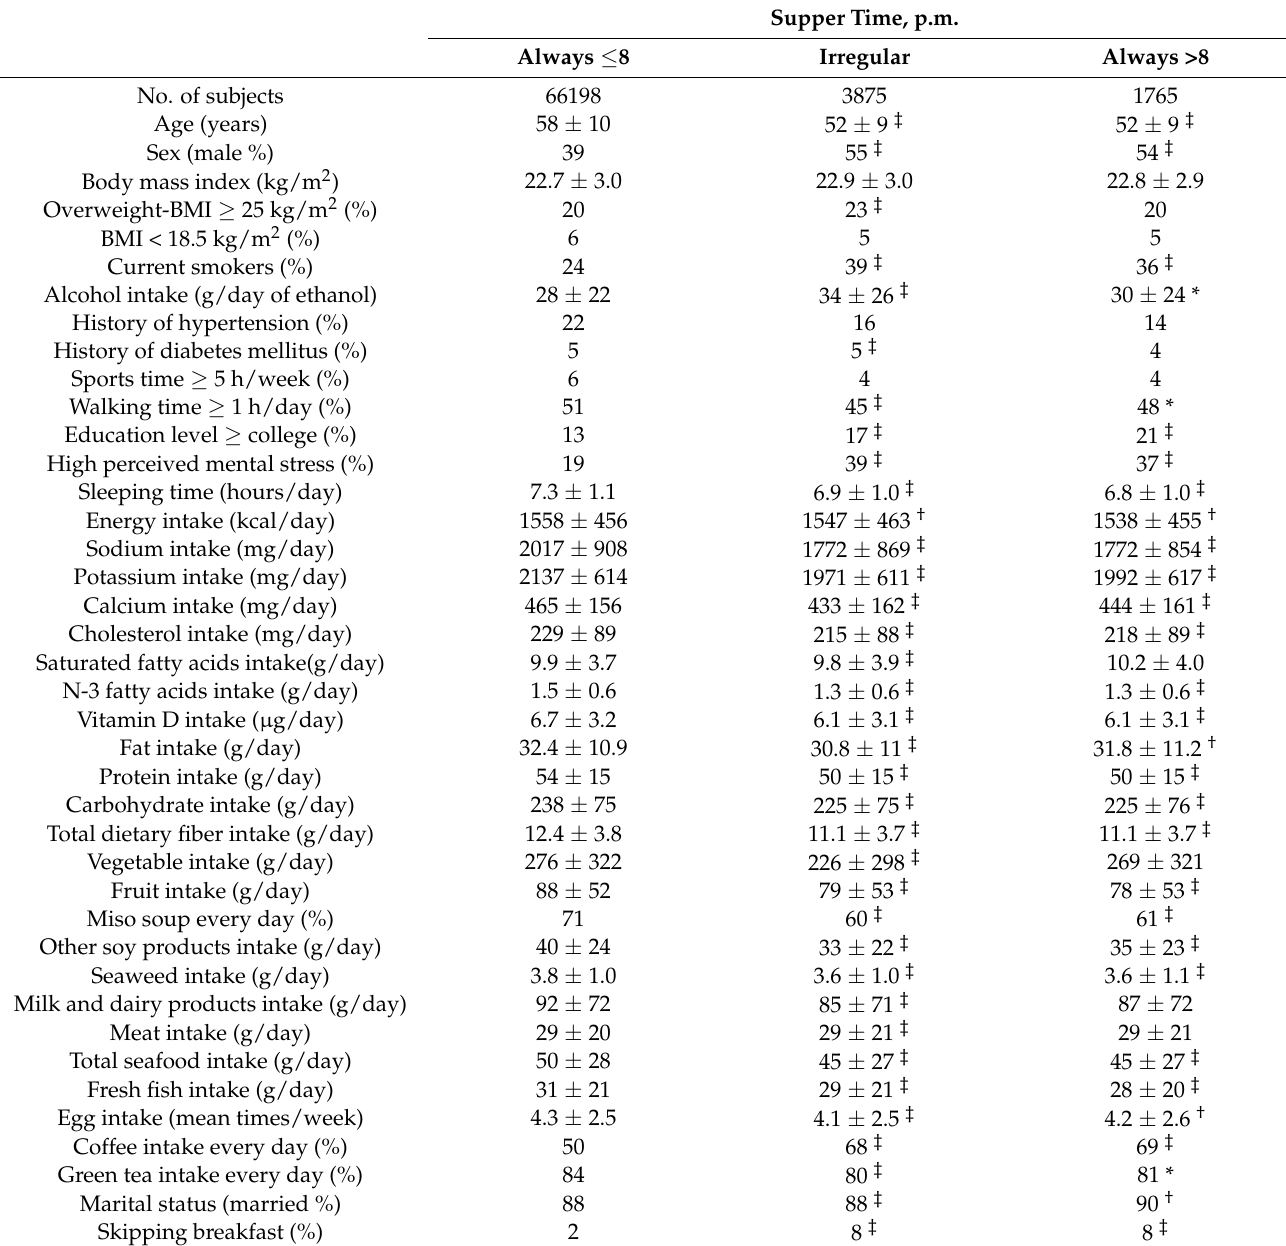
Table 1. Baseline characteristics and risk factors (means ± standard deviations) and proportions of participants by supper time.